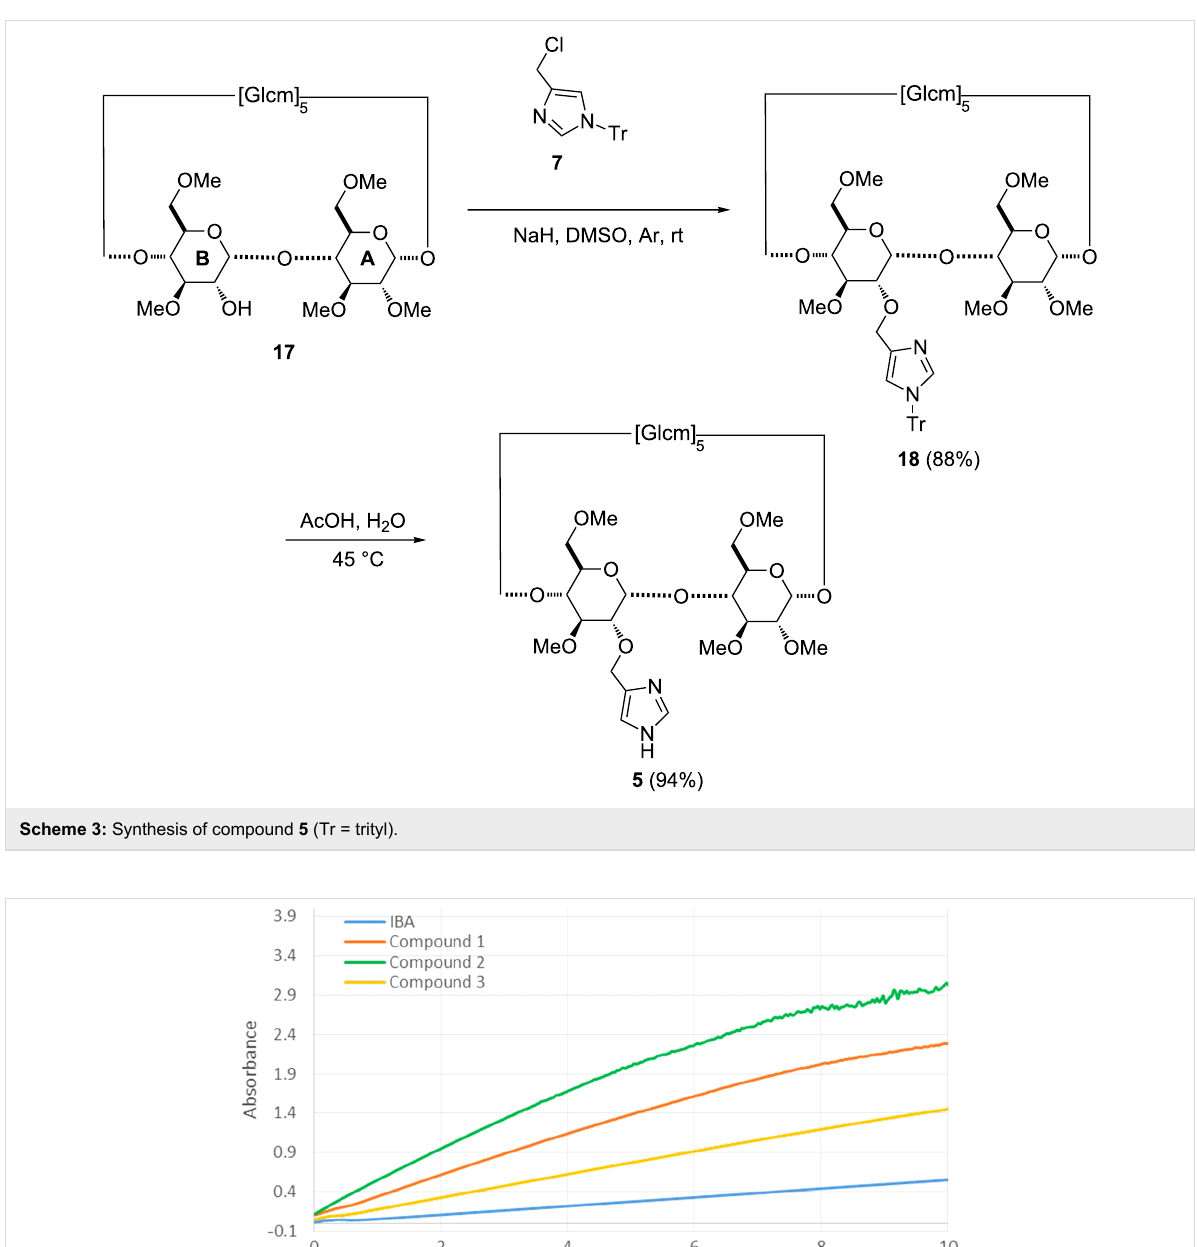
Figure 5: Hydrolysis of methyl paraoxon (0.5 mM) in the presence of compounds 1 , 2 , 3 or 2-iodosobenzoic acid (IBA) at 0.25 mM concentration.